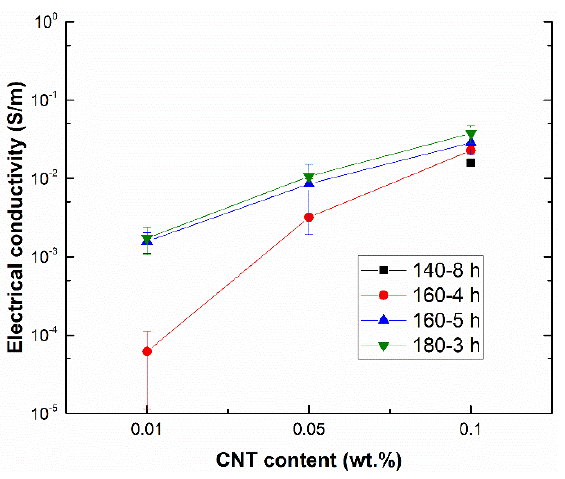
Figure 6. Electrical conductivity measurements for the different tested conditions.